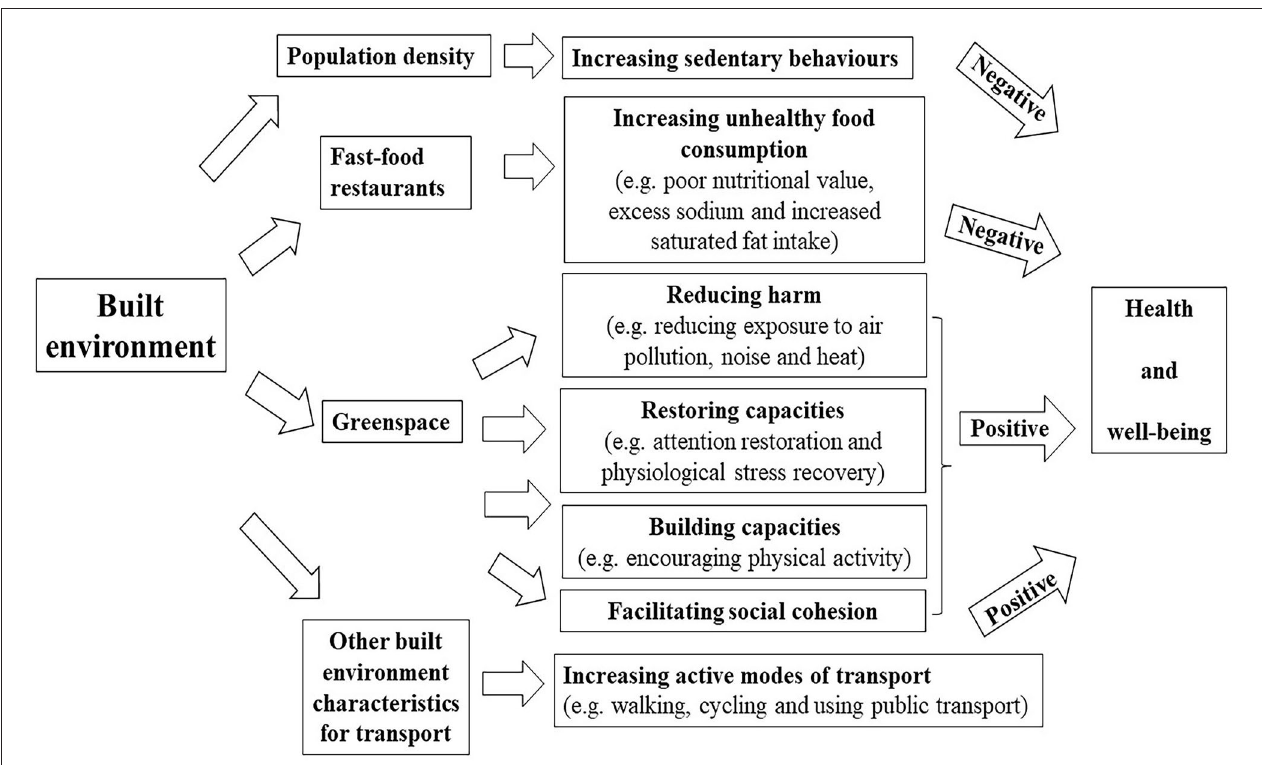
FIGURE 5 | Pathways linking built environment (fast food restaurant and greenspace) to health outcomes (negative: there is a negative effect; positive: there is a positive effect).